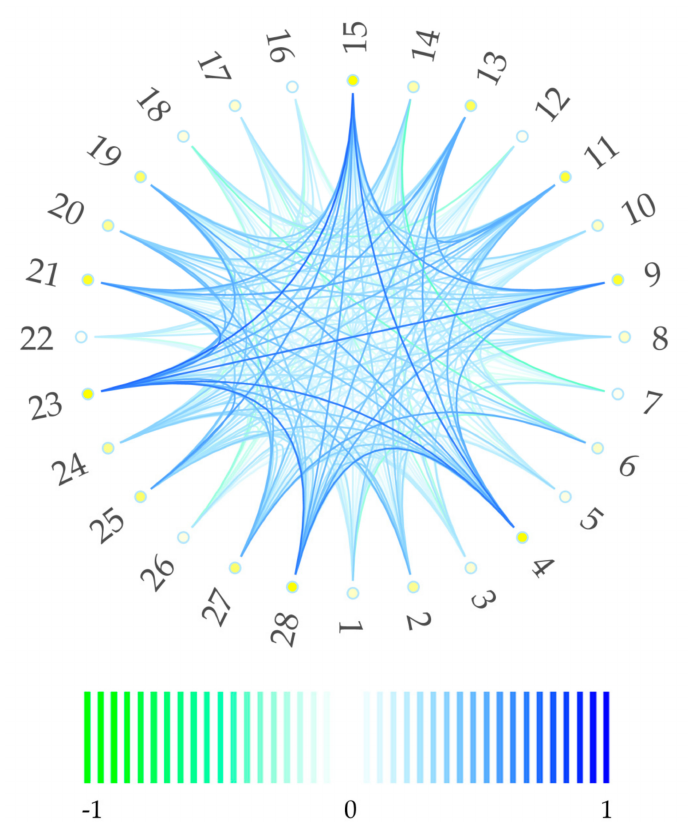
Figure 4. Schemaball illustration of Pearson correlations between participants. The numbers around the circle represent the participants, the color of the connecting lines (green to white to blue) represents the coe ffi cient, and the color of the dots next to the number represents the average coe ffi cient of the participant.